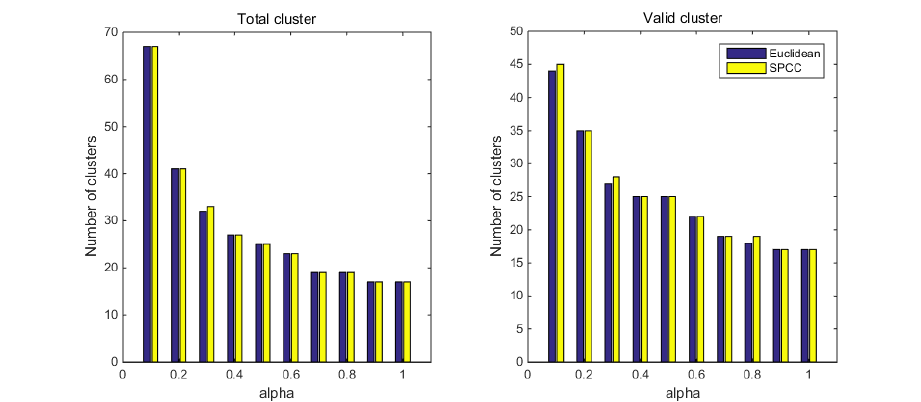
Figure 10. Comparison in number of clusters formed from DOE data set.